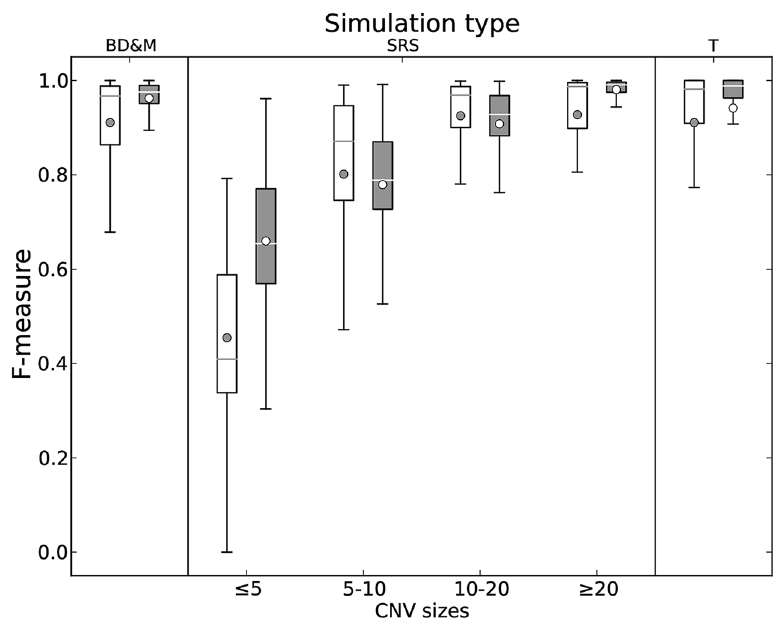
Fig 2. F-measures of CBS (light) and HaMMLET (dark) for calling aberrant copy numbers on simulated aCGH data [66]. Boxes represent the interquartile range (IQR = Q3 − Q1), with a horizontal line showing the IQR beyond Q1 and Q3), and the bullet representing the median (Q2), whiskers representing the range ( 3 2 mean. HaMMLET has the same or better F-measures in most cases, and on the SRS simulation converges to 1 for larger segments, whereas CBS plateaus for aberrations greater than